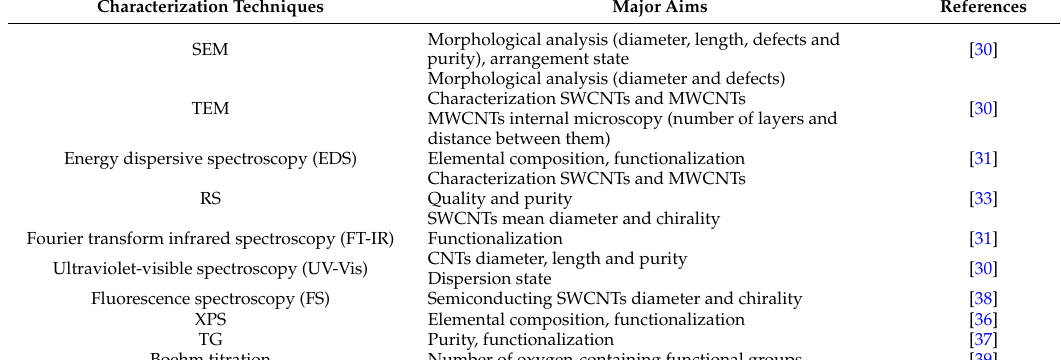
Table 1. Characterization techniques of CNTs.